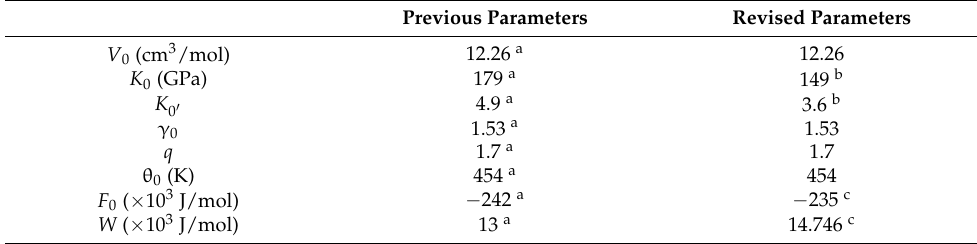
Table 2. Thermodynamic parameters for FeO employed in partitioning and phase equilibrium modeling: 1 bar volume V 0 , 1 bar bulk modulus K 0 , pressure-derivative of the bulk modulus K 0 (cid:48)